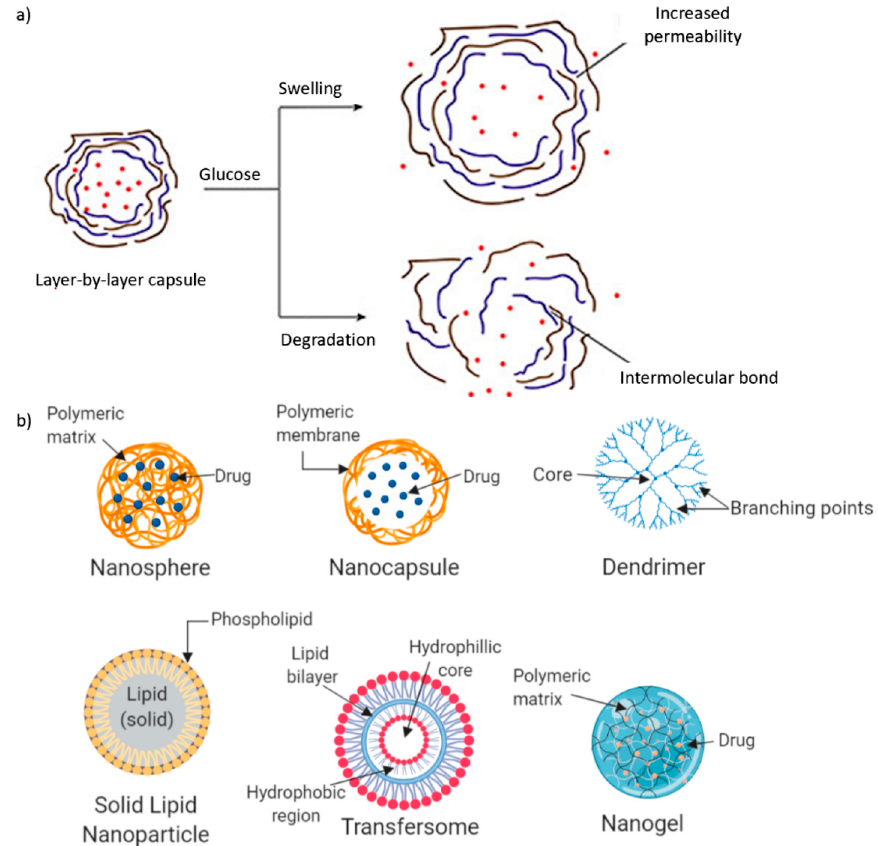
Figure 4. ( a ) Schematic illustrating the mechanism of layer-by-layer insulin nanoparticle capsules and ( b ) illustrating the nanosphere, nanocapsules, dendrimers, SLNs, transfersomes, and nanogel platforms for insulin loading and delivery (adapted with permission from Reference